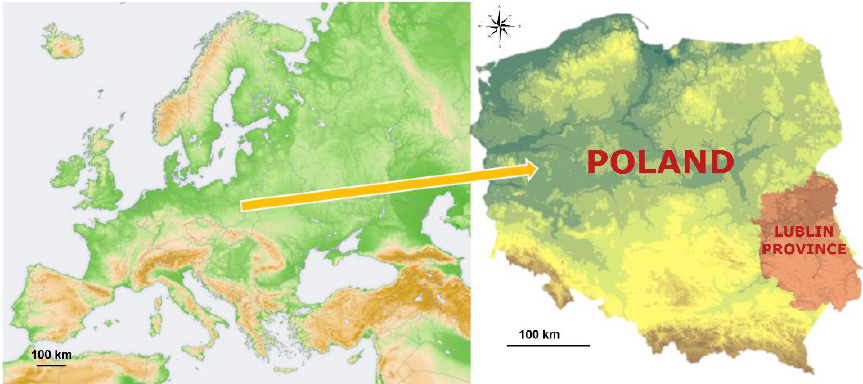
Figure 1. Maps of the study area in Eastern Poland, based on Wikimedia [39,40] with our own modifications.